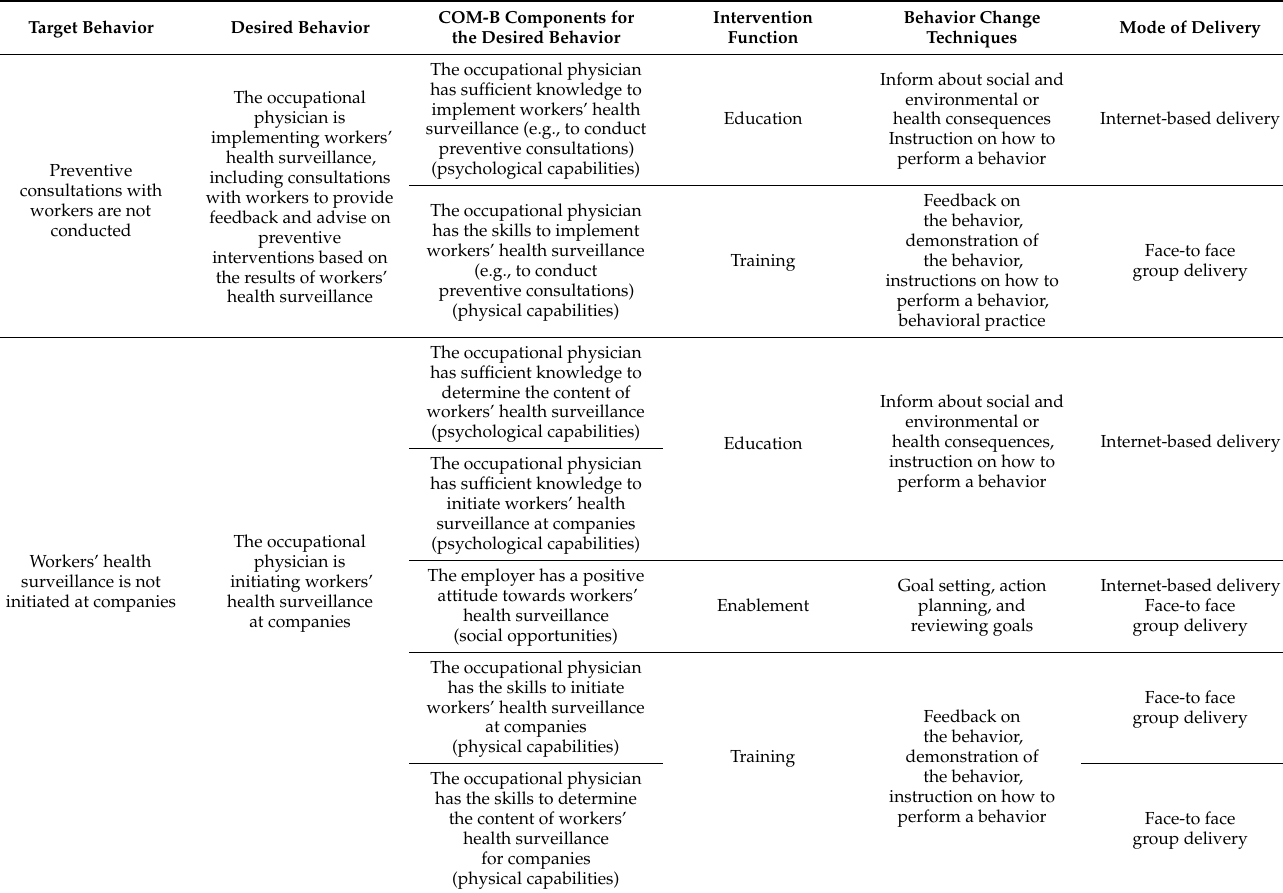
Table 1. Combined link between behavior capability, opportunity, and motivation (COM-B), intervention functions, behavior change techniques, and mode of